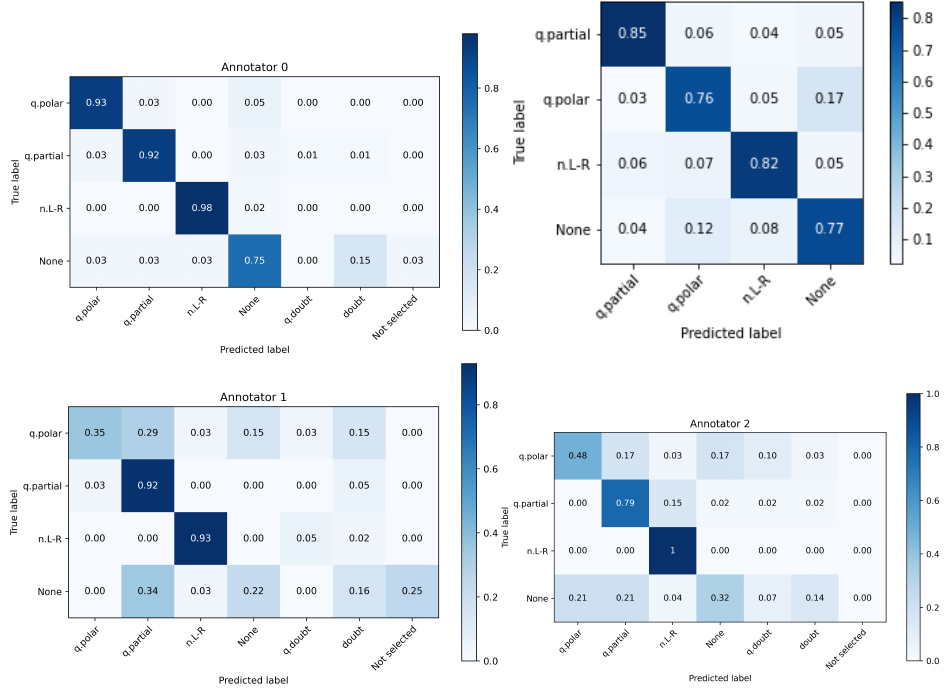
Figure 12. Confusion matrices of the interpreters against the original labels of LSE_GFE. Upper right shows the best automated